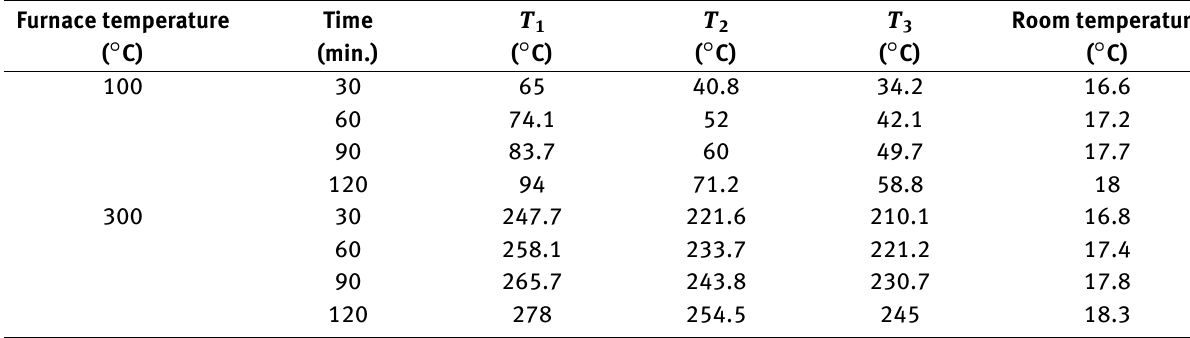
Table 3: Experimental results at different temperatures of uncoated specimen Furnace